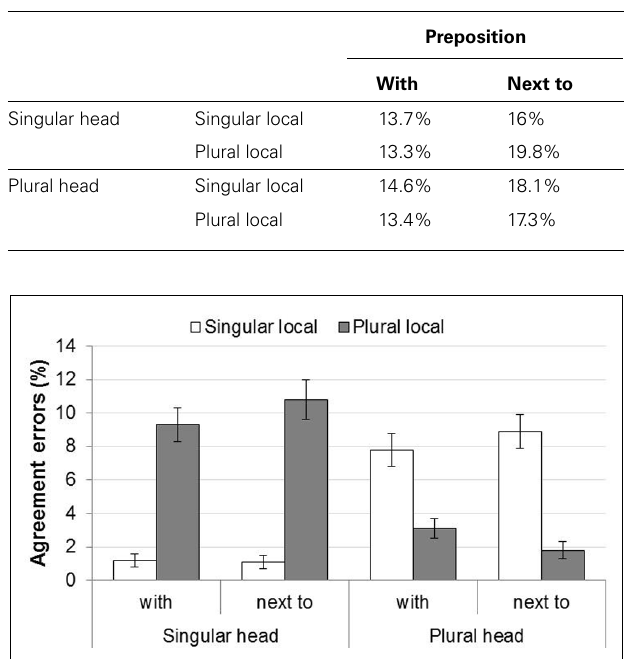
FIGURE 1 |Agreement errors in Experiment 1. Error bars show the SE of the mean across participants, for illustrative purposes.